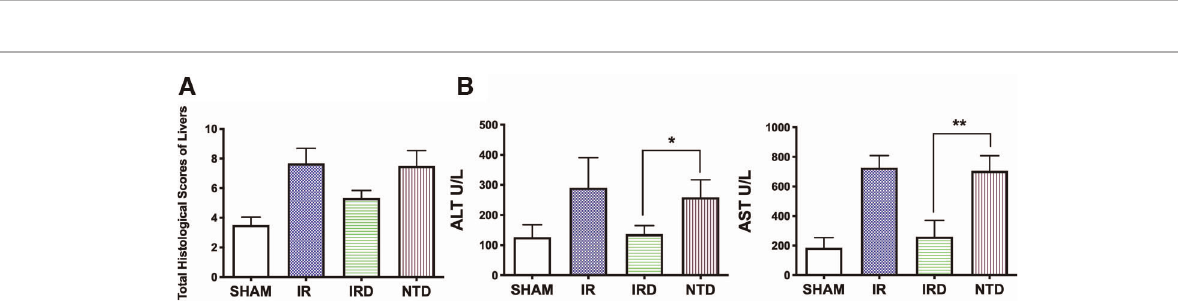
FIGURE 1 | DADLE treatment attenuated hepatic IRI in cirrhotic livers by decreasing pathological scores and ALT and AST levels. ( A ) H&E staining and Suzuki score after a 6- h reperfusion. Original magni fi cation 400×, n =6, * p <0.05. ( B ) Serum ALT and AST levels in each group after 6 h reperfusion; n =6, * p <0.05; ** p <0.01. IR, ischemia – reperfusion injury group; IRD, DOR agonist DADLE treatment